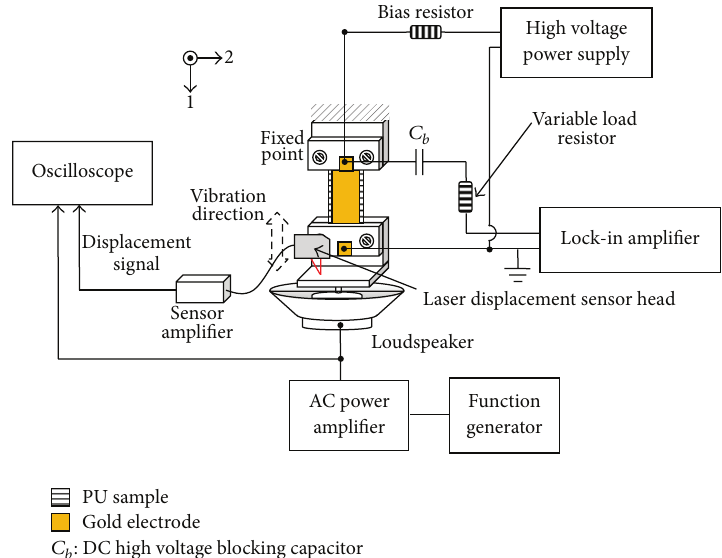
Figure 1: Aschematic view of the power harvesting setup.